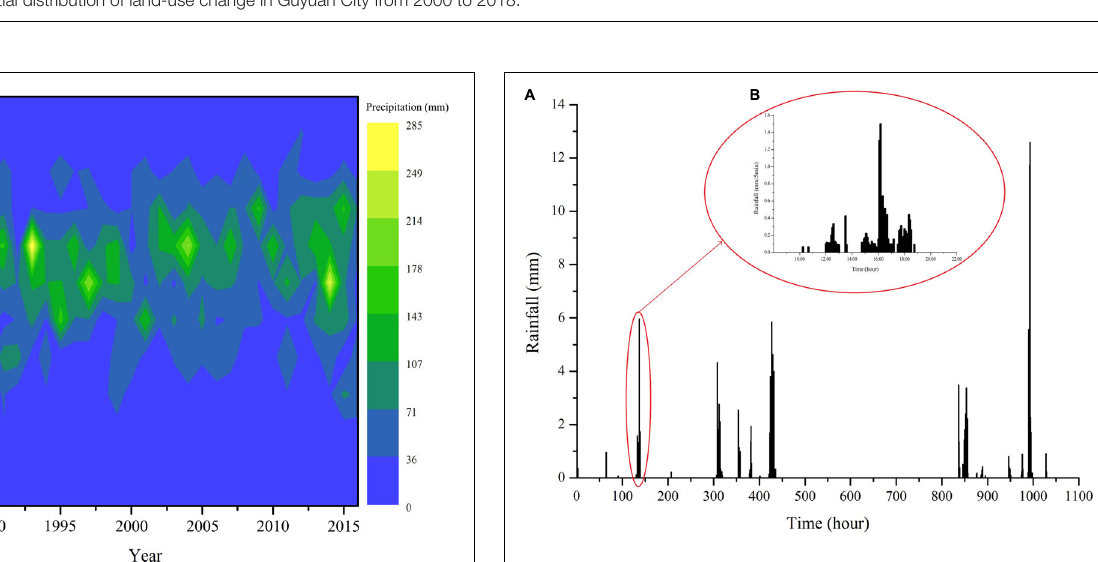
FIGURE 3 | Spatial distribution of land-use change in Guyuan City from 2000 to 2018.